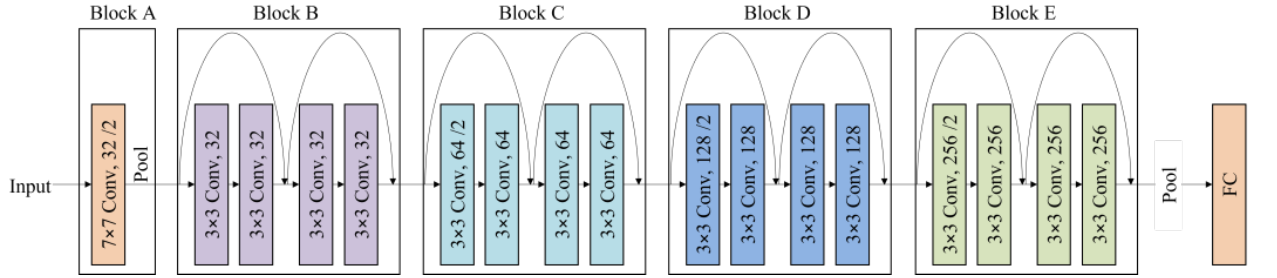
Figure 9. ResNet18 architecture with half the parameters for lightweighting.